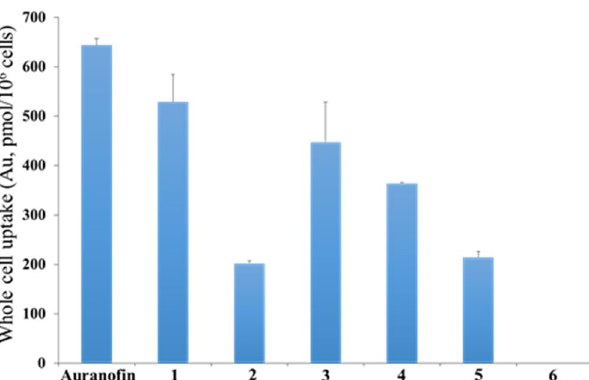
Figure 8. Whole cell (OVCAR8) uptake results from auranofin (5 μ M) and complexes 1 – 6 (5 μ M). Cells were incubated with compounds for 15